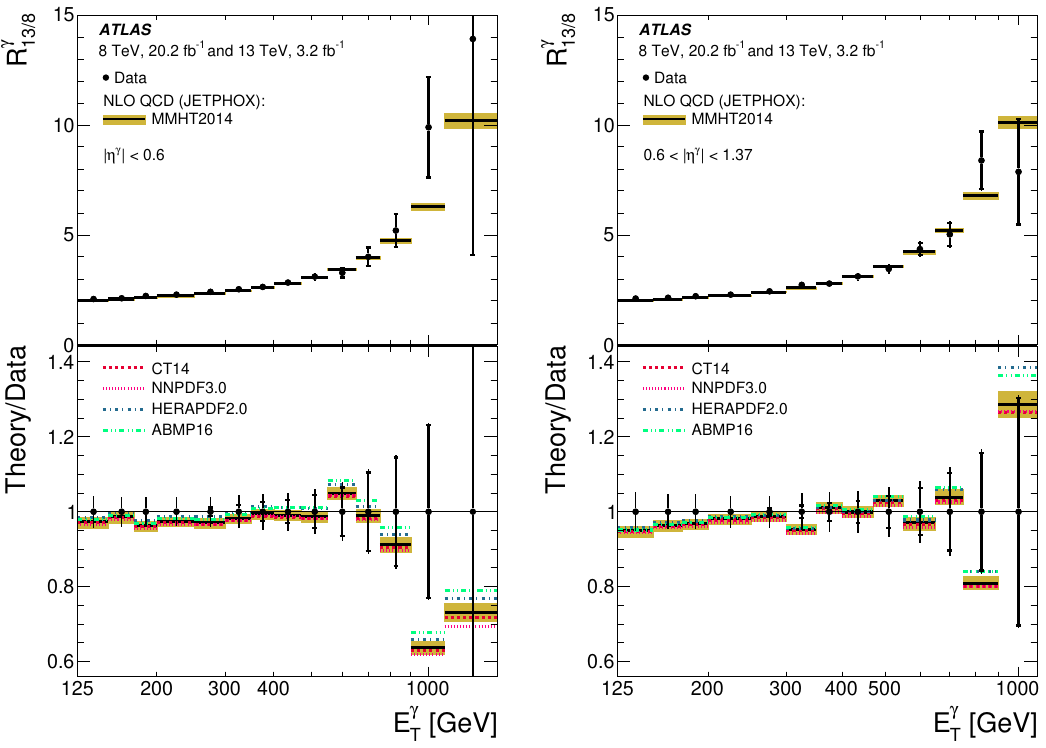
Figure 6 . The measured R (cid:13) (dots) as a function of E (cid:13) in di(cid:11)erent regions of j (cid:17) (cid:13) j . The NLO T 13 = 8 QCD predictions based on the MMHT2014 PDFs (black lines) are also shown. The inner (outer) error bars represent the statistical (total) uncertainties. The shaded band represents the theoretical uncertainty in the predictions. For most of the points, the error bars are smaller than the marker size and, thus, not visible. The lower part of the (cid:12)gures shows the ratio of the NLO QCD predictions based on the MMHT2014 PDFs to the measured R (cid:13) (black lines). The ratios of the NLO QCD 13 = 8 predictions based on di(cid:11)erent PDF sets to the measured R (cid:13) are also included. 13 = 8